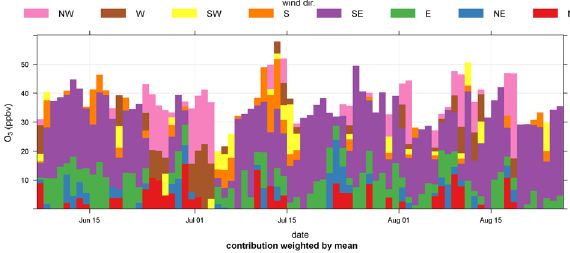
Fig. 4 O 3 time series plot categorised into wind sectors. Daily variation in O 3 concentrations by proportional contributions of wind sectors (north, northeast, east, southeast, south, southwest, west and northwest). The O 3 concentrations are represented as stacked bars to show the proportional contribution of each wind sector.